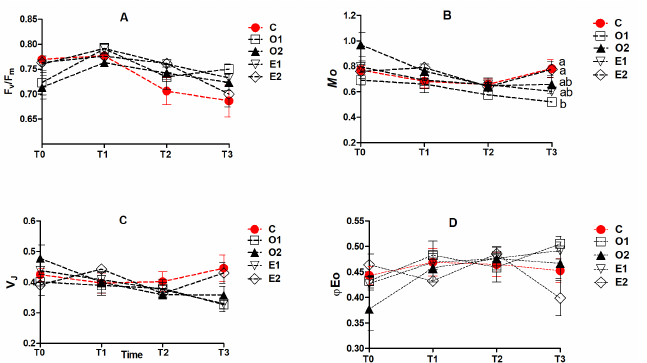
Figure 7. JIP -test parameters were calculated from the fluorescence measurements. reported for Control (C, closed circle, red) and treated plants (O1, square; O2, closed triangle; E1, open triangle; E2, diamond). ( A ) Fv , the maximum quantum yield of PSII for primary photochemistry; ( B ) V J = Fm ( F 300 µ s − F 0 ) ( FJ − F 0 ) , indicating the level of QA reduction; ( C ) Mo = 4 , corresponding to the net rate ( Fm − F 0 ) ( Fm − F 0 ) × Yo , the quantum yield of of the reaction center closure; ( D ) φ Eo = Fv Fm